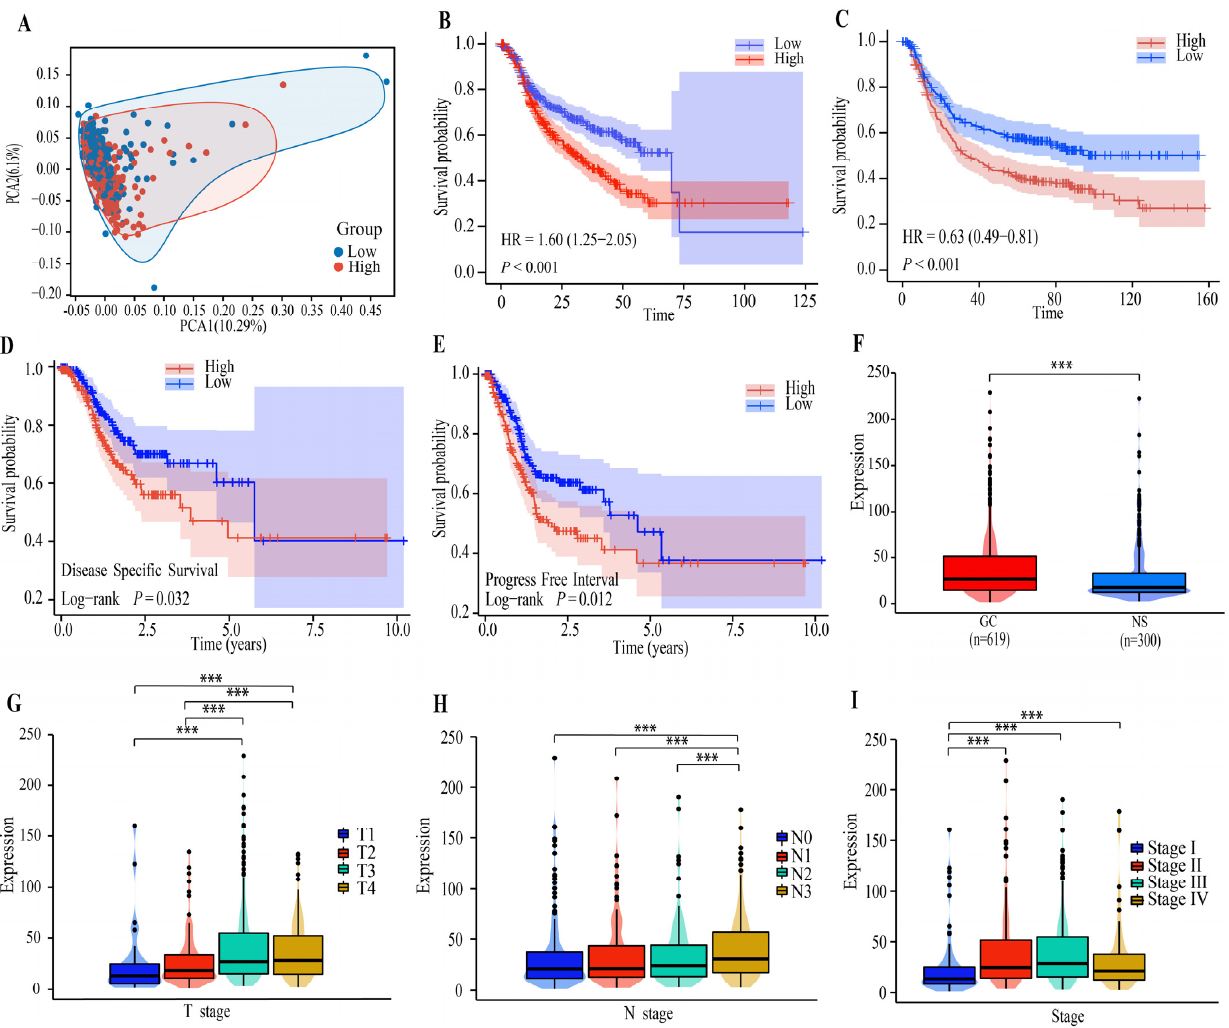
Figure 1. The associations between the FBLN5 mRNA expression levels and prognostic and clinico- pathological features. ( A ) The PCA analysis assessed the grouping situation of patients with different levels of FBLN5 expression. ( B ) Overall survival analysis of patients with high- and low-expression levels of FBLN5 in the HMU-TCGA database ( p < 0.001). ( C ) Overall survival analysis of patients with high- and low-expression levels of FBLN5 in the GEO database ( p < 0.001). ( D ) DSS analysis of patients with high- and low-expression groups of FBLN5 ( p < 0.05). ( E ) PFI analysis of patients with high- and low-expression groups of FBLN5 ( p < 0.05). ( F ) Analysis of the differential expression of FBLN5 in GC (619 cases) and normal tissues (300 cases). ( G – I ) The expression of FBLN5 in GC tissues in patients with different grades of disease ( p < 0.05). *** p < 0.001. (HMU, Harbin Medical University; TCGA, the Cancer Genome Atlas; GEO, gene expression omnibus; GC, gastric cancer; DSS, disease-specific survival; PFI, progress-free